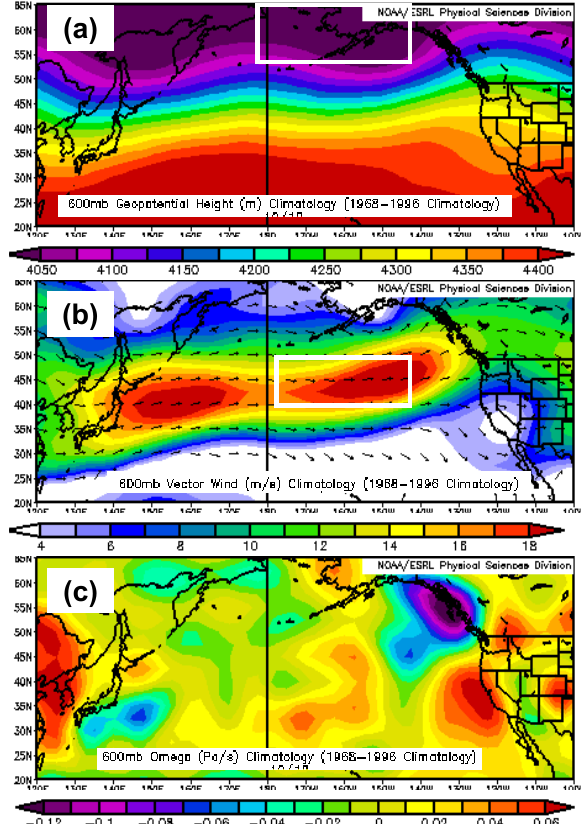
Figure 7. Climatology of synoptic-scale meteorological parameters during 15 Apr - 20 May from NCEP reanalysis (http://www.esrl.noaa.gov/psd/data/composites/day/) at 600 hPa (i.e., the free troposphere): (a) geopotential height, (b) vector winds, and (c) vertical velocity. The white boxes in (a) and (b) indicate regions where substantial anomalies occurred during spring 2009, as highlighted in Fig. 8(c) and (f) and discussed in Sect. 3.4.